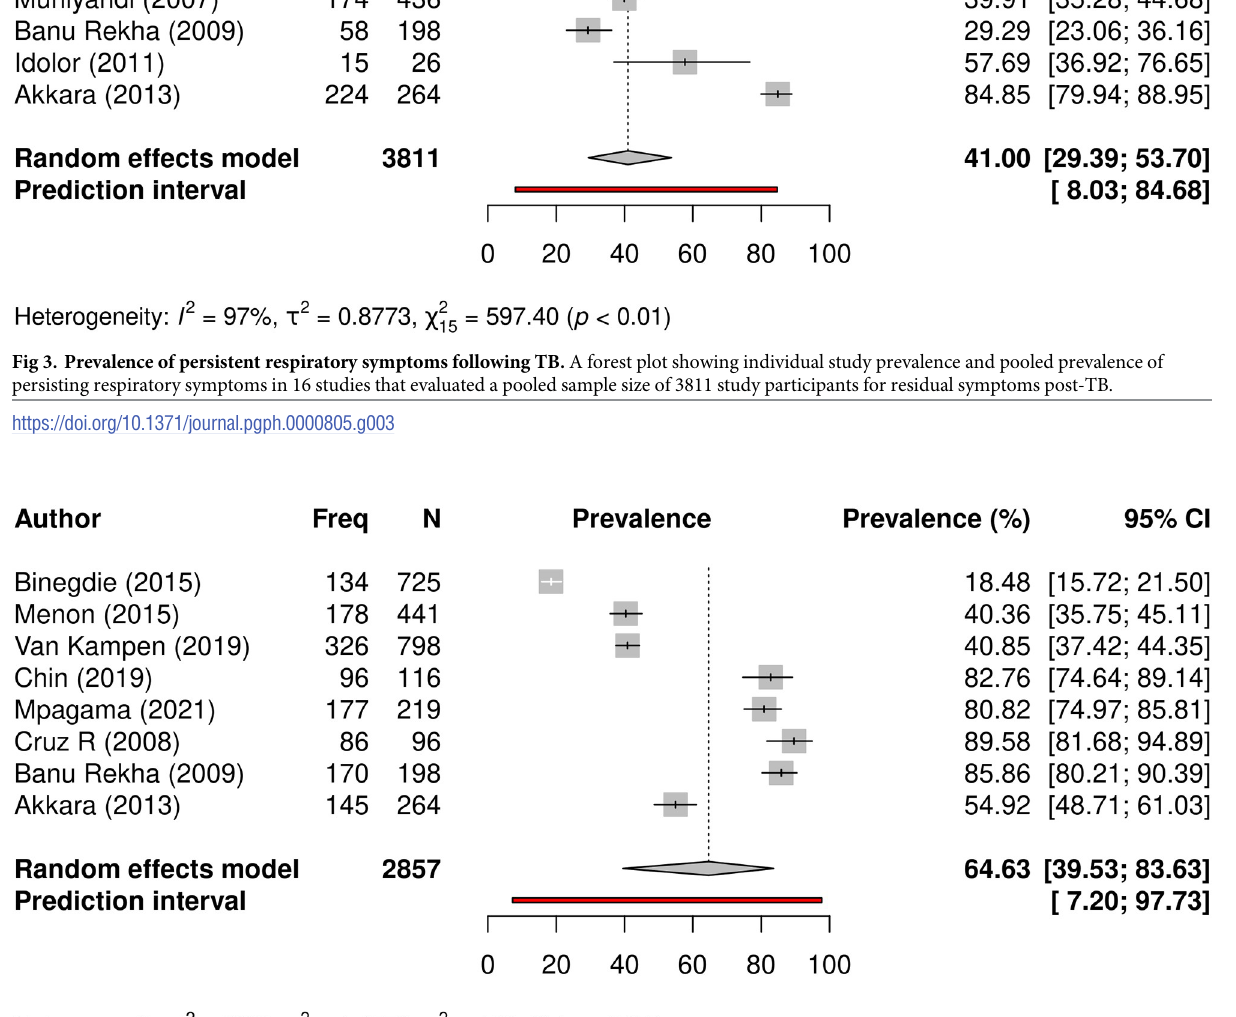
PLOS Global PublicHealth | https://doi.org/10.1371/journal.pgph.0000805 December 20, 2022 11 /